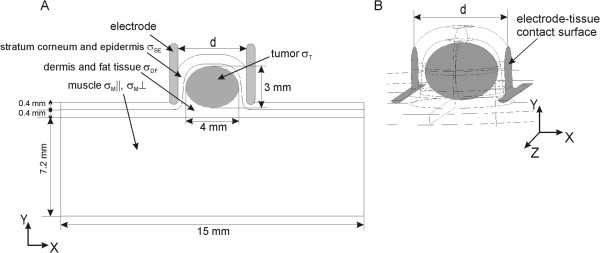
Geometry of numerical model of subcutaneous tumor. A. The geometry dimensions and composition of cutaneous tumor model. (The electrodes in this figure only sketch the site of electrodes’ position in the experiments and do not take part of the numerical model) and B. 3D geometry of tumor model with the contact surface between tissue and electrodes. The distance between plate electrodes was d = 5.2 mm.